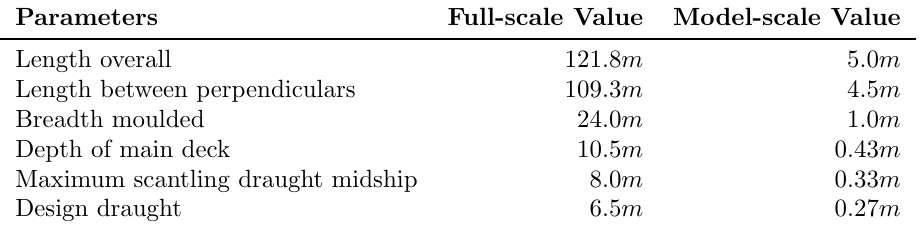
Table 1: Main dimensions of the CIVArctic vessel